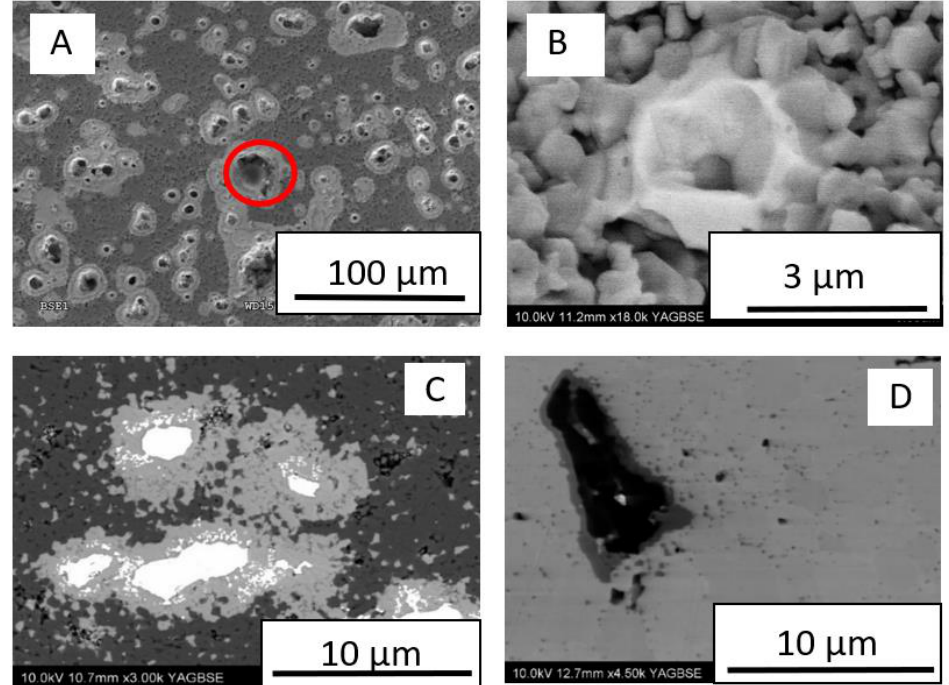
Figure 6. SEM images of ceramic–metal composites: ( A ) Al 2 O 3 -Ni composite, spinel phase NiAl 2 O 4 (light grey)—in red circle are the Ni particles pulled out from the matrix visible; ( B ) Al 2 O 3 -Fe composite, voids after Fe particles have been pulled out, and spinel FeAl 2 O 4 around the void is visible; ( C ) Al 2 O 3 -Ni composite, spinel phase NiAl 2 O 4 (light grey) located around the Ni particles; ( D ) ZrO 2 -Ti composite, Ti particle (black) and Ti oxides (dark grey) around the particles as well as at ceramic grain boundaries. Source: results obtained under supervision of K.